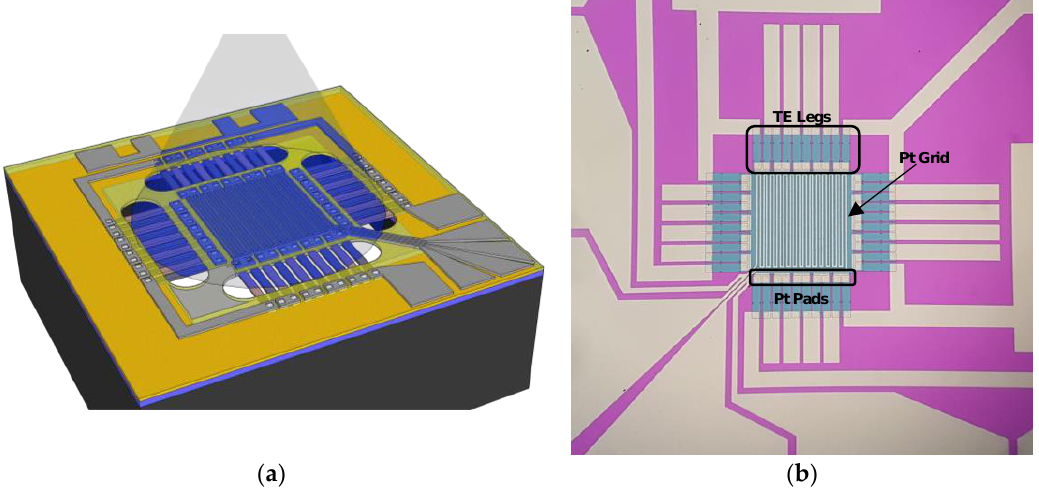
Figure 1. ( a ) Schematic of the device showing the illuminated area. ( b ) Optical image of the device presenting thermoelectric (TE) legs, Pt grid and Pt pads.